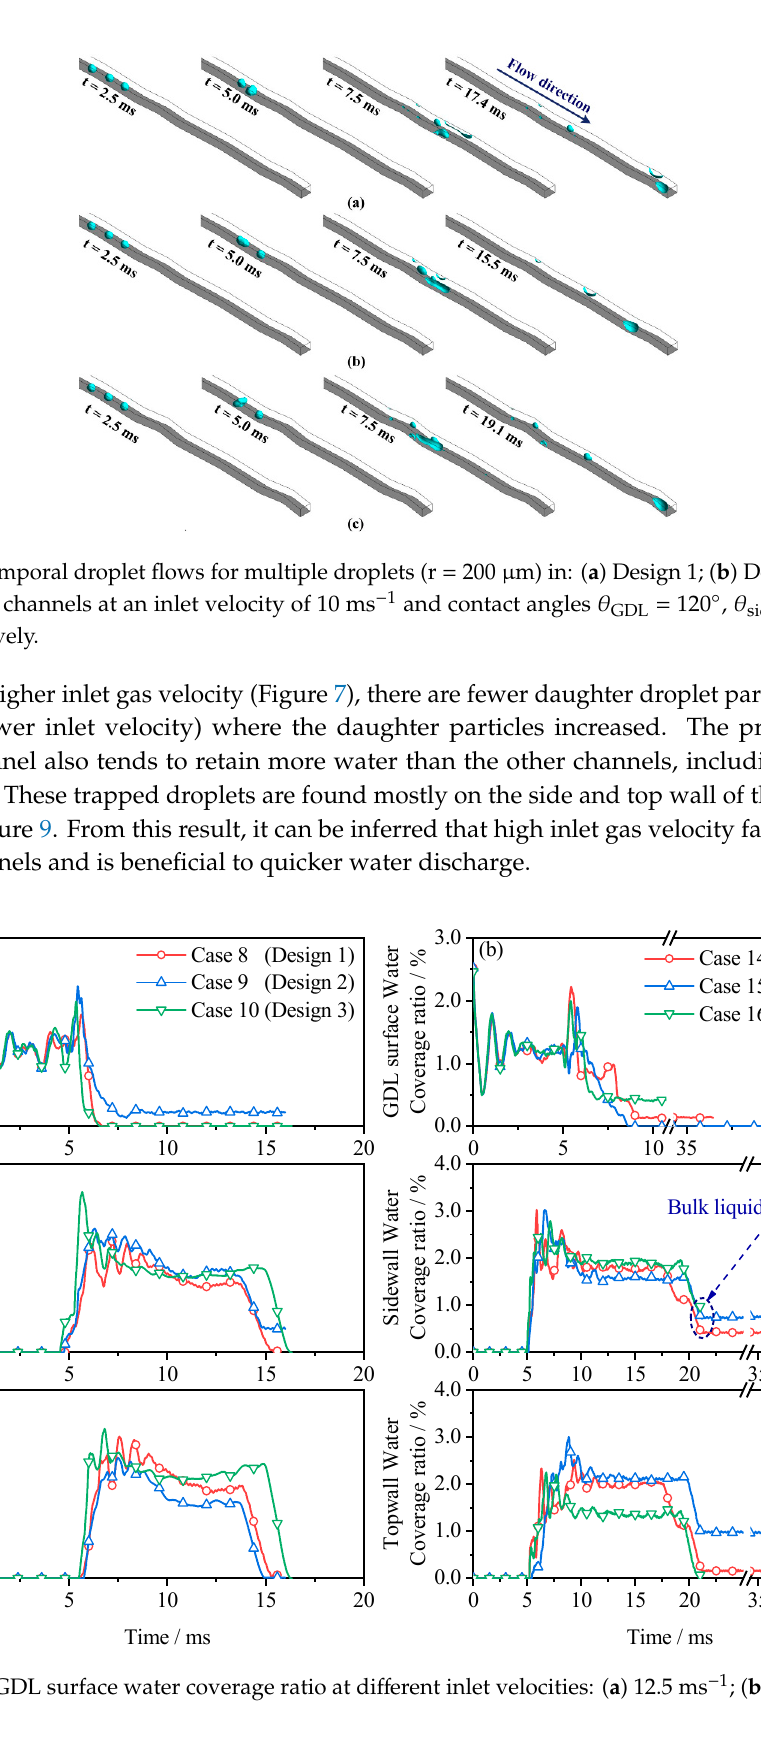
Figure 7. Temporal droplet flows in: ( a ) Design 1; ( b ) Design 2; and ( c ) Design 3 channels at an inlet velocity of 12.5 ms − 1 and contact angles θ GDL = 120°, θ side; top = 82°; 82° respectively.